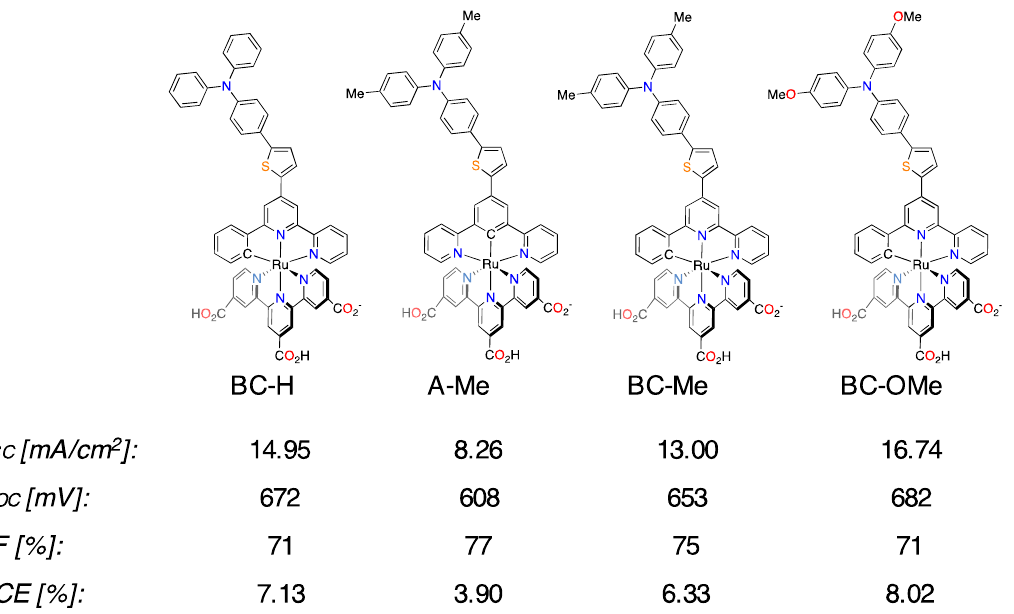
Figure 16. Performance of cyclometalated ruthenium sensitizers with tridentate ligands in solar cells [107] . With N3 sensitizer and electrolyte optimized for presented new sensitizers J SC , V OC , FF, and PCE of 16.48 mA/cm 2 , 713 mV, 74%, and 8.65% respectively were achieved. Reported titled for sensitizers are different than in original work.